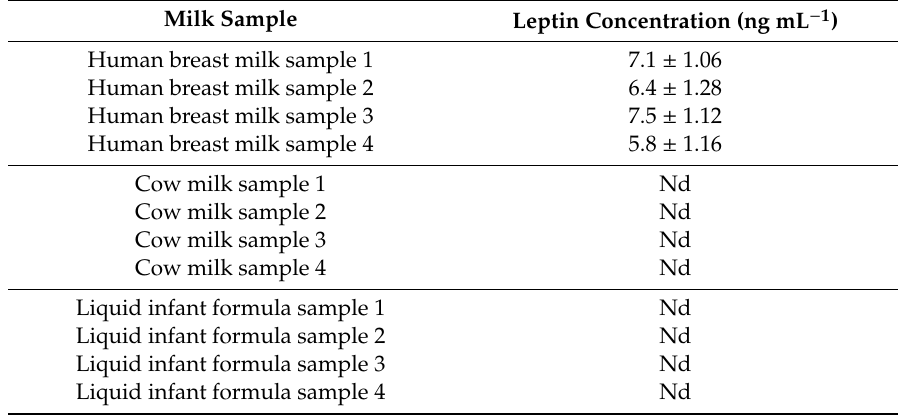
Table 3. Concentration value of leptin in human breast milk, cow milk and liquid infant formula samples. The amount is expressed in ng · mL − 1 . Nd, not detectable.